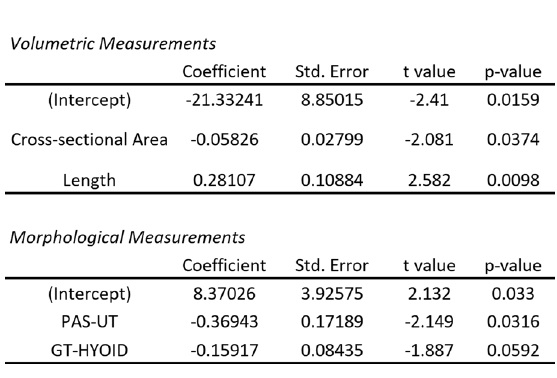
Table VI. Volumetric and morphologic variables and tongue channelling